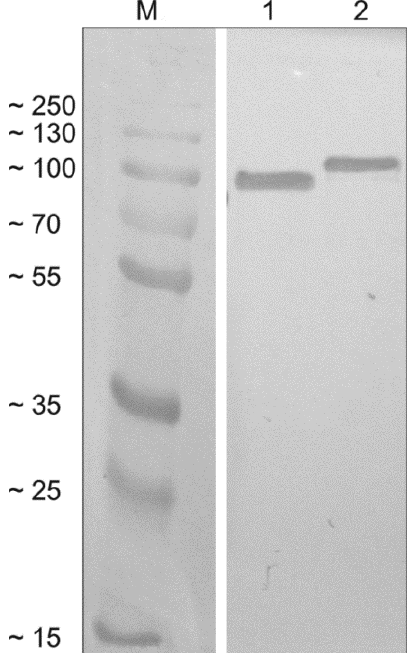
Figure 2. Western blot analysis of the tetravalent recombinant chimeric proteins. Recombinant proteins SAG1-MIC1-MAG1-GRA2 (SMMG; lane 1) and SAG2-GRA1-ROP1-GRA2 (SGRG; lane 2) were detected using specific anti-His antibodies and compared to the protein marker (M).